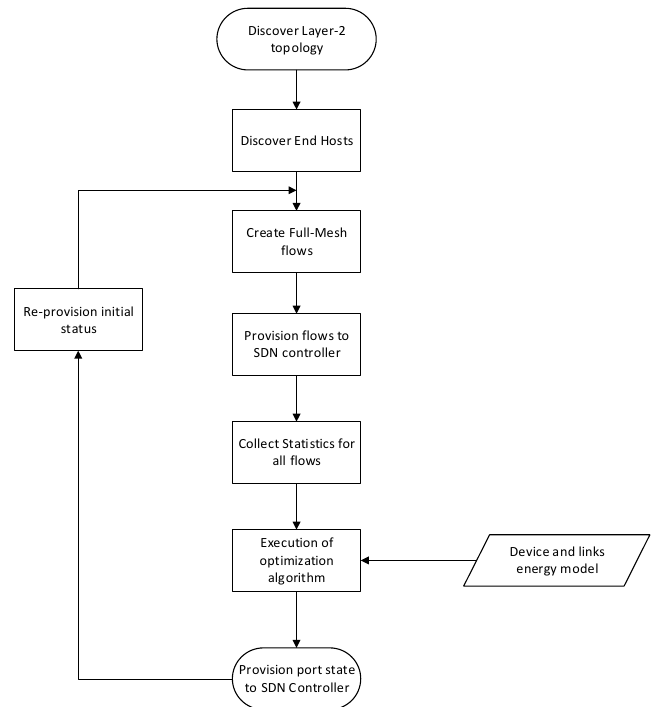
Figure 5. Software defined networking (SDN) application internal sequence of activities.